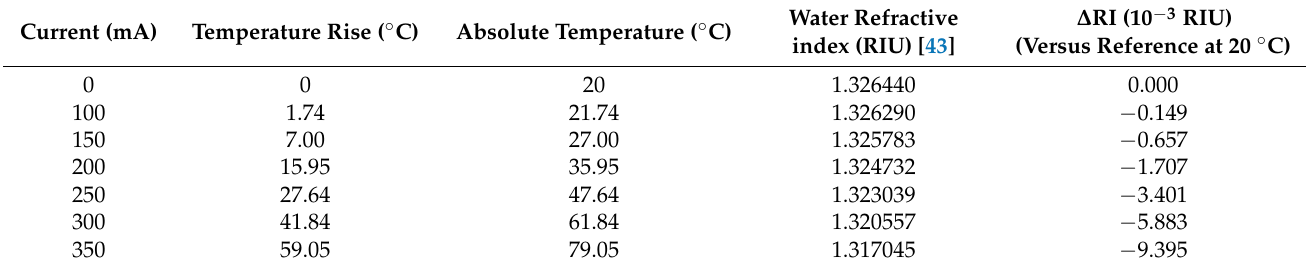
Table 3. Driving currents, corresponding temperature rises, and water refractive